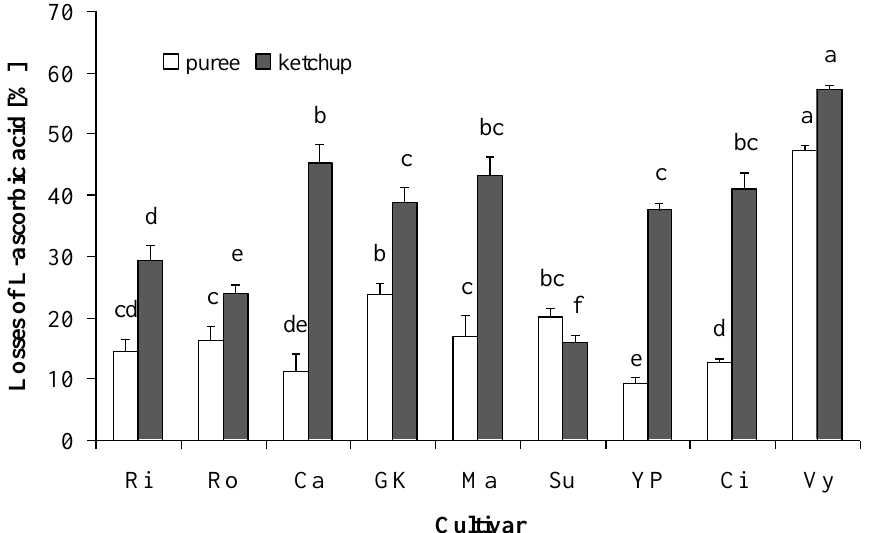
Figure 2. Losses of L-ascorbic acid in tomato cultivars after processing to puree and ketchup relative to fresh tomato fruits (Ri—‘Rilia’, Ro—‘Roma’, Ca—‘Campbell-28’, GK—‘Goldene Königin’, Ma—‘Marmande’, Su—‘Suso’ F1, YP—‘Yellow Pearshaped’, Ci—‘CIMA’, Vy—‘Vyta’). The losses were calculated based on data presented in Table 1. The loss of ascorbic acid content of the fresh tomato fruits is 0 by definition. Different letters indicate significant differences within each processing method for cultivars by Duncan test at p ≤ 0.05, n = 16.